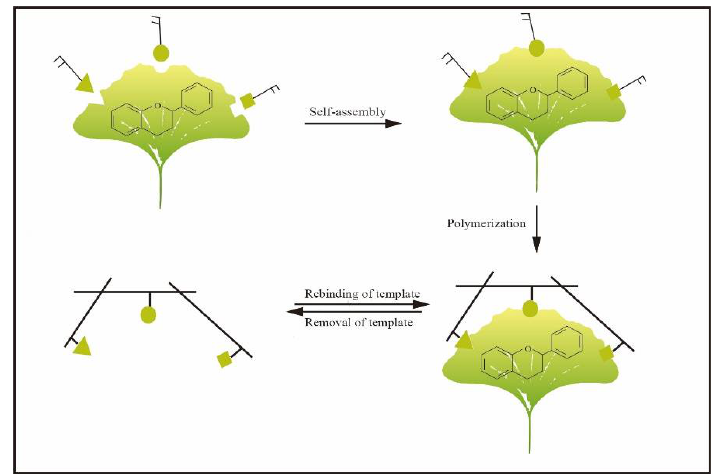
Figure 2. Principle of MIPs preparation.